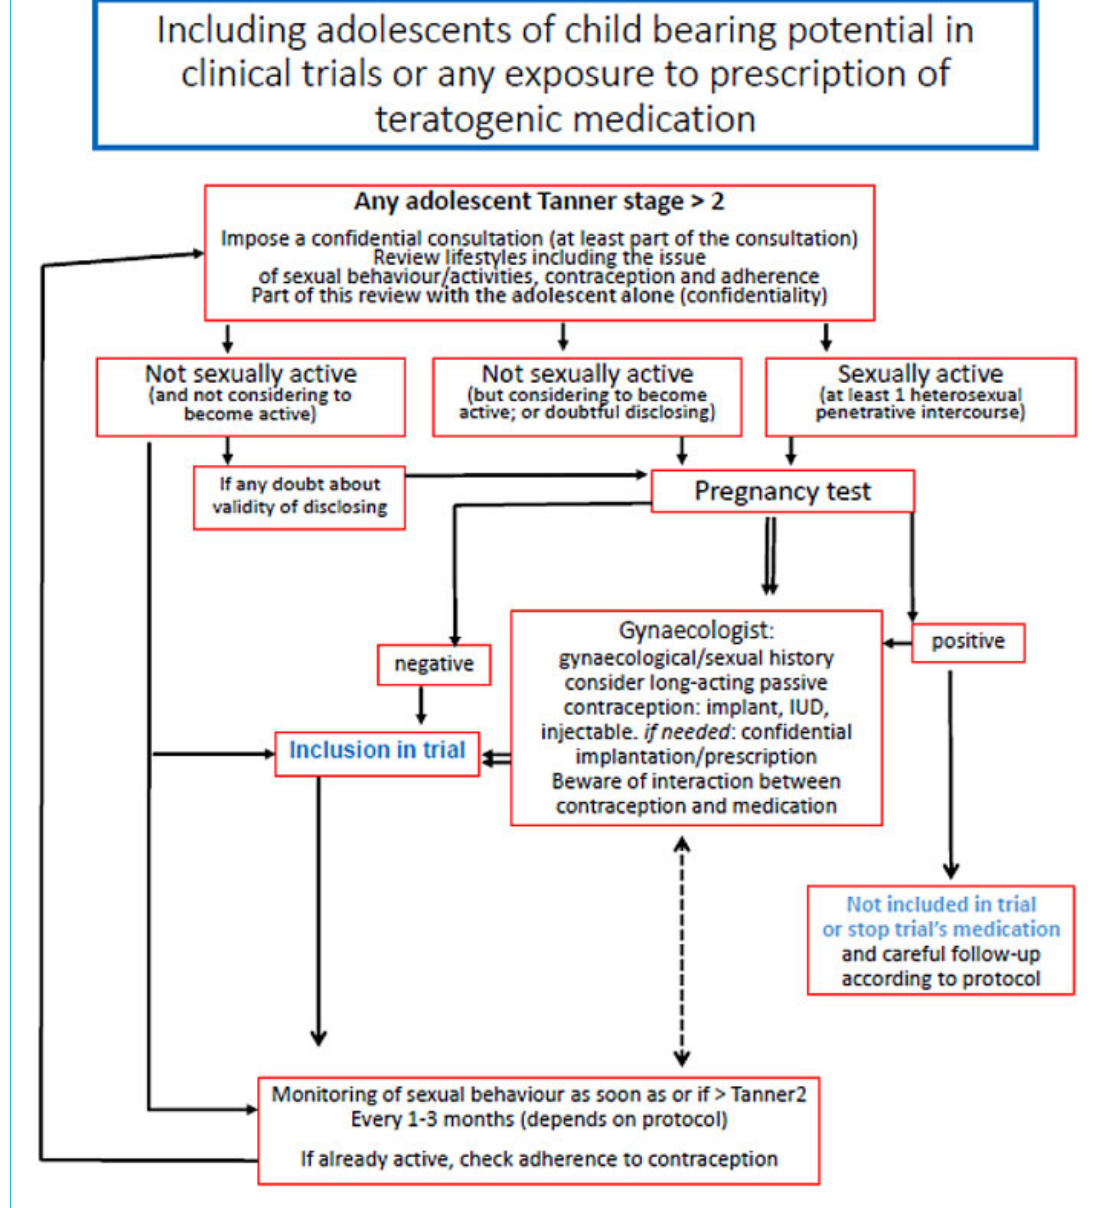
Figure 2: A decision-making algorithm regarding the involvement of childbearing potential adolescents in clinical